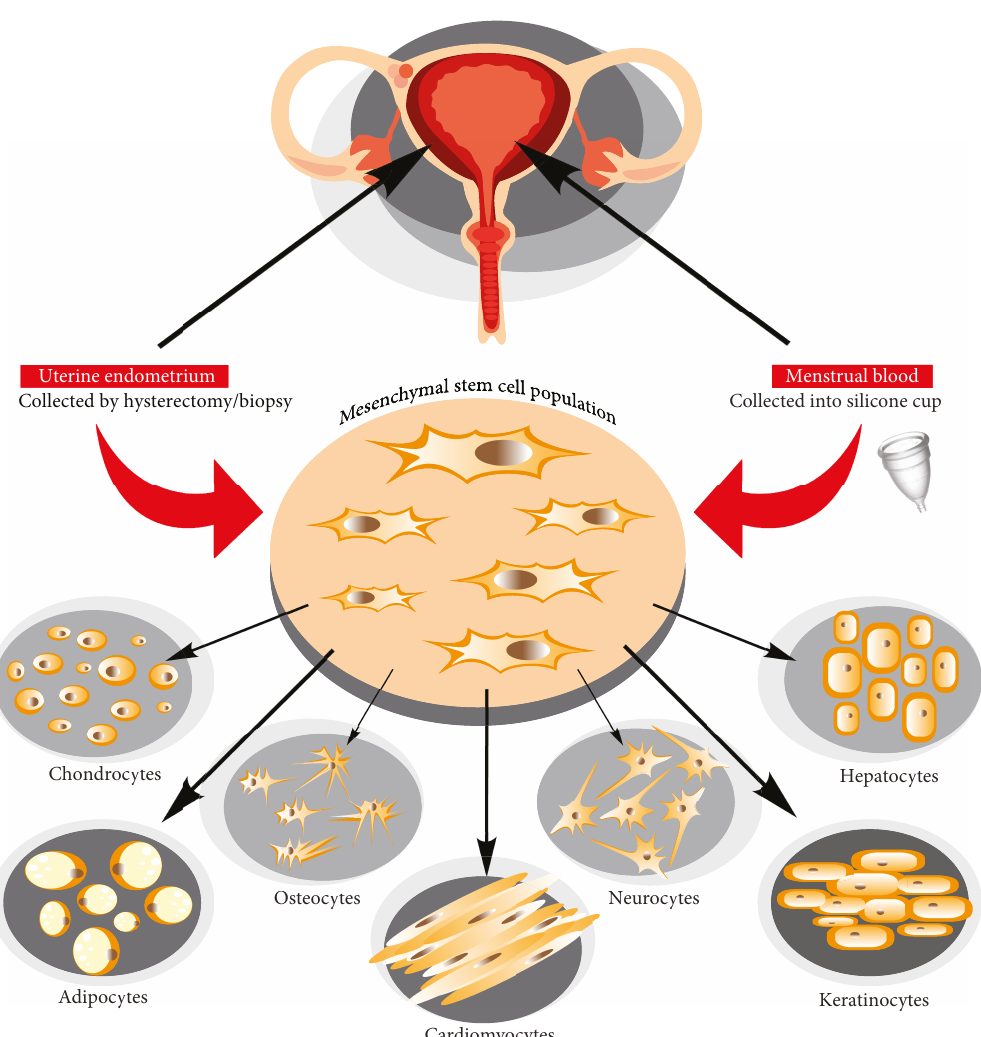
Figure 1: Mesenchymal stem cell isolation from uterine endometrium and menstrual blood and their di ff erentiation